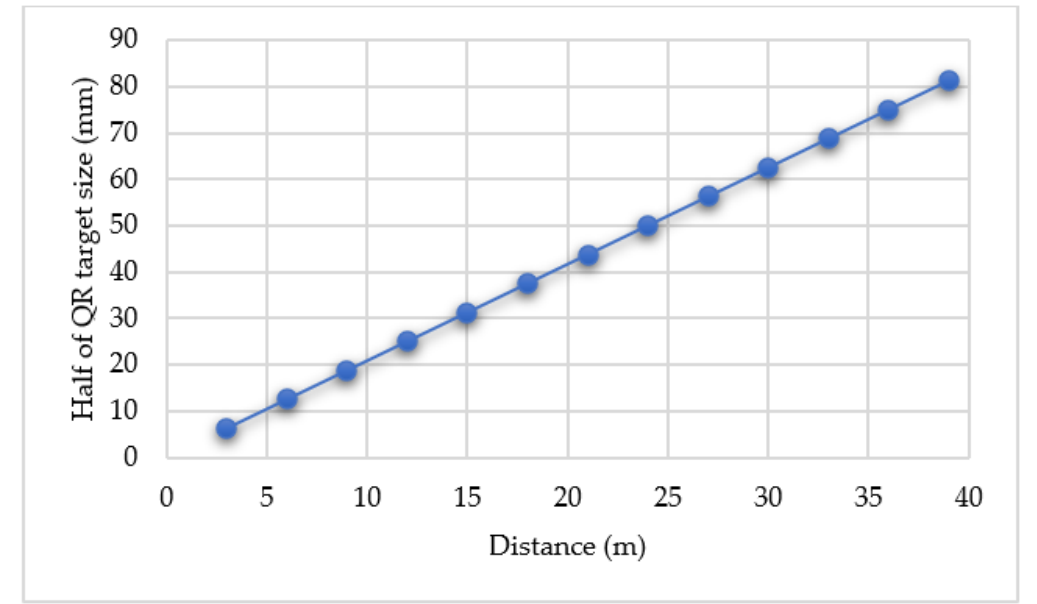
Figure 13. The QR target size at the different distances.